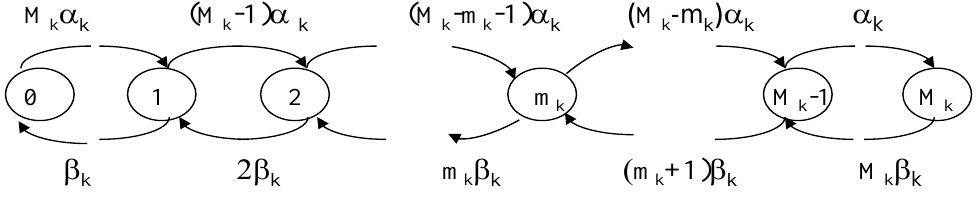
Figure 6. Markov modulated